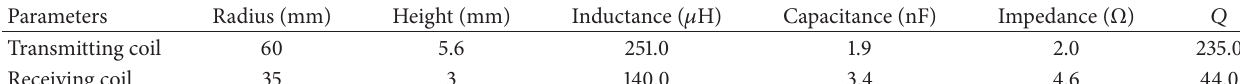
Table 2: Parameters of transmitting coil and receiving coil.